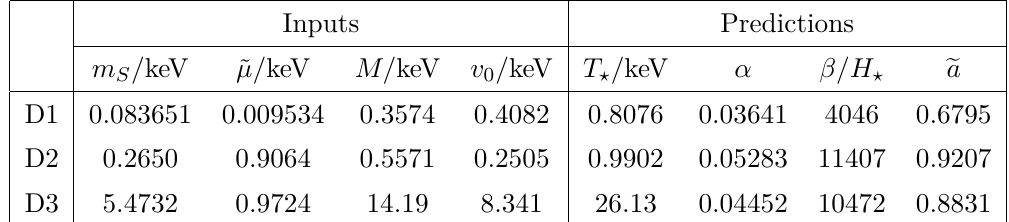
Table 4 . Values of the parameters corresponding to the three benchmark (starred) points in figure